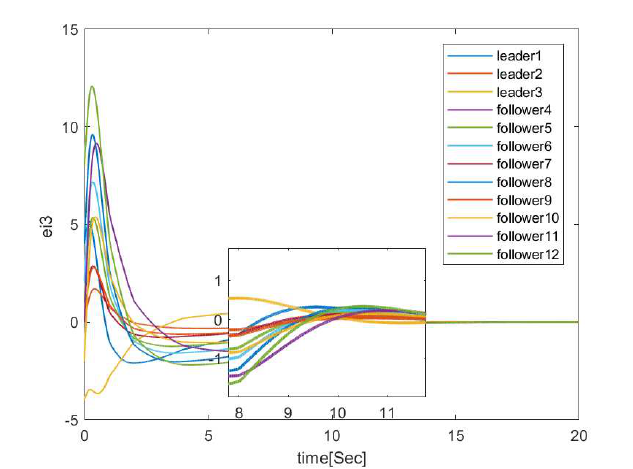
Figure 4. Position State Component 3 of Agent without delay.